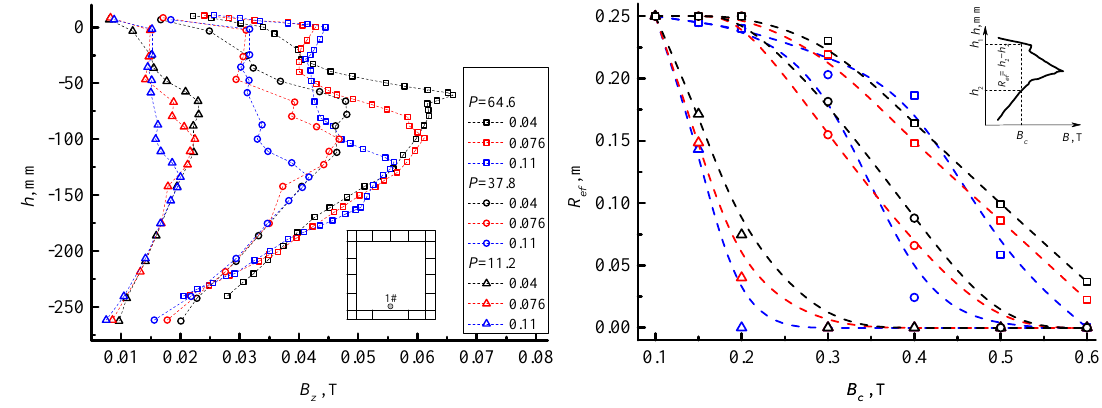
Figure 3. ( Left ): Variations of the magnetic flux density B z along the casting direction at testing location 1# for different h m and P . ( Right ): the critical magnetic flux density B c vs . the effective acting region R ef . The legends are the same as that on the